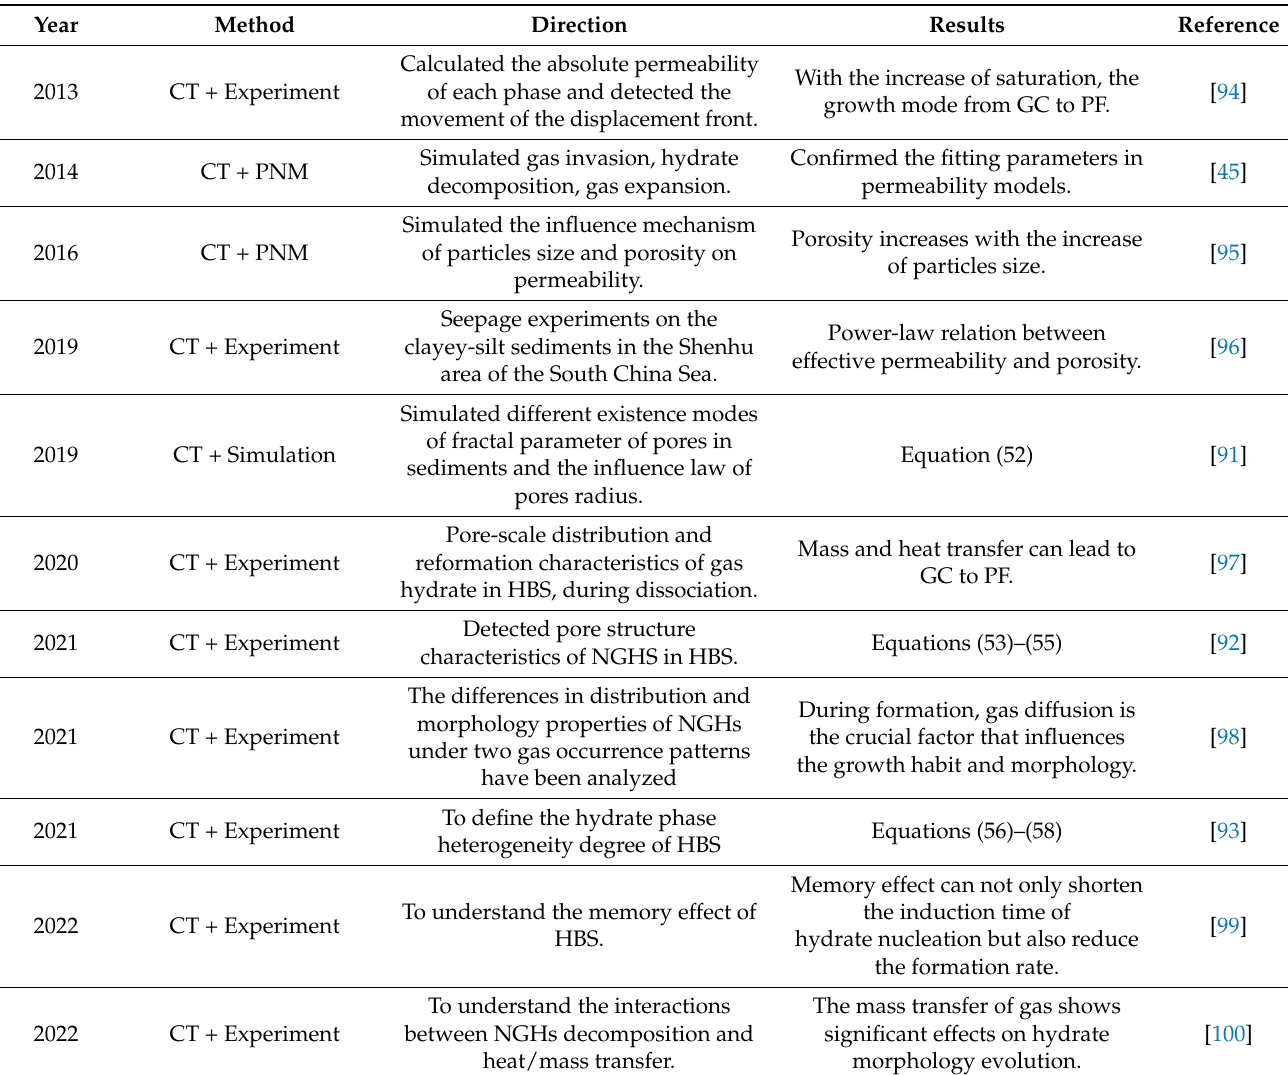
Table 4. The application of CT technique to hydrate seepage